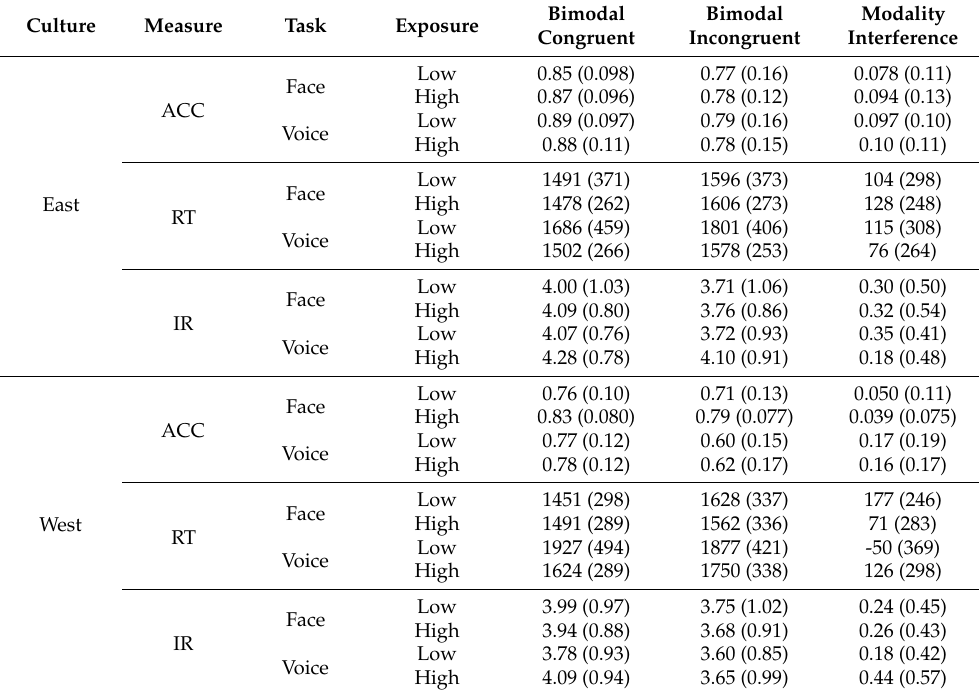
Table 5. Mean accuracy rates (ACC), response times in ms (RT), and intensity ratings (IR) across cultures, tasks, level of exposure to Western culture, and conditions (standard deviations are in